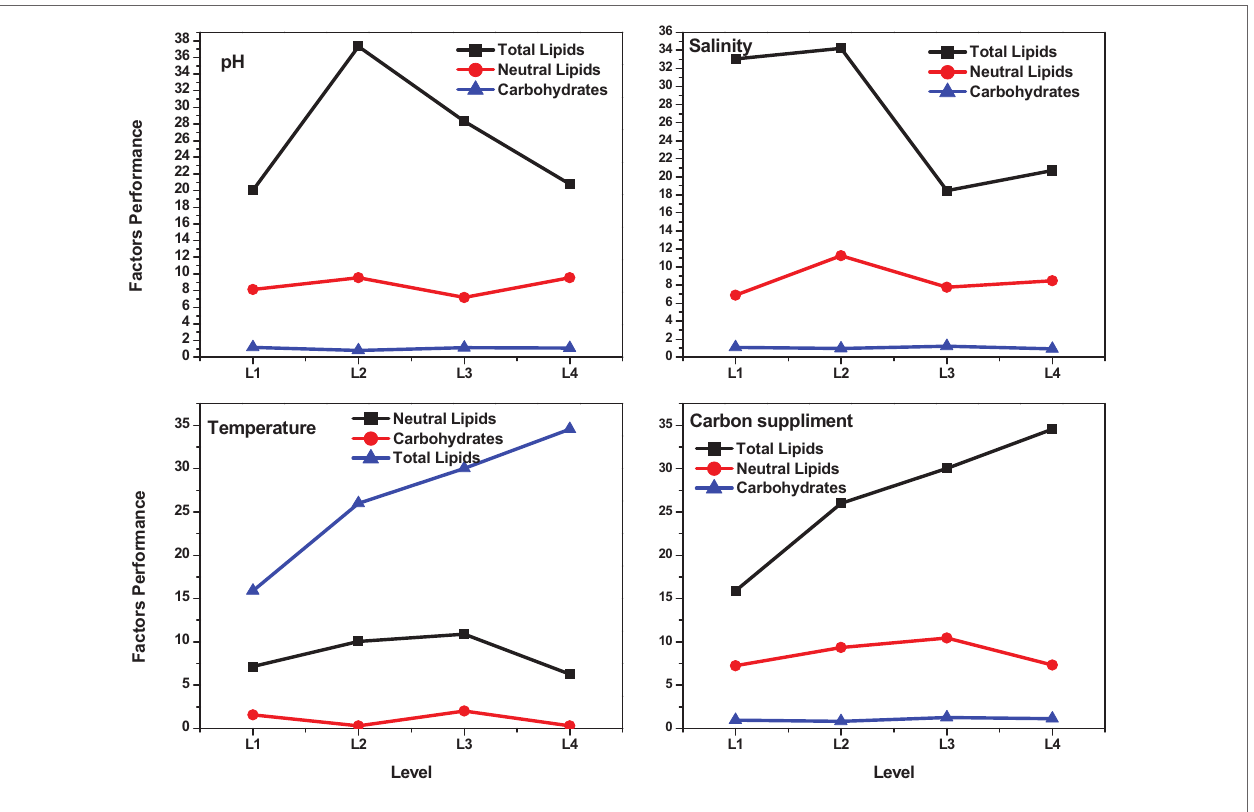
FigUre 4 | individual factors performance at different levels